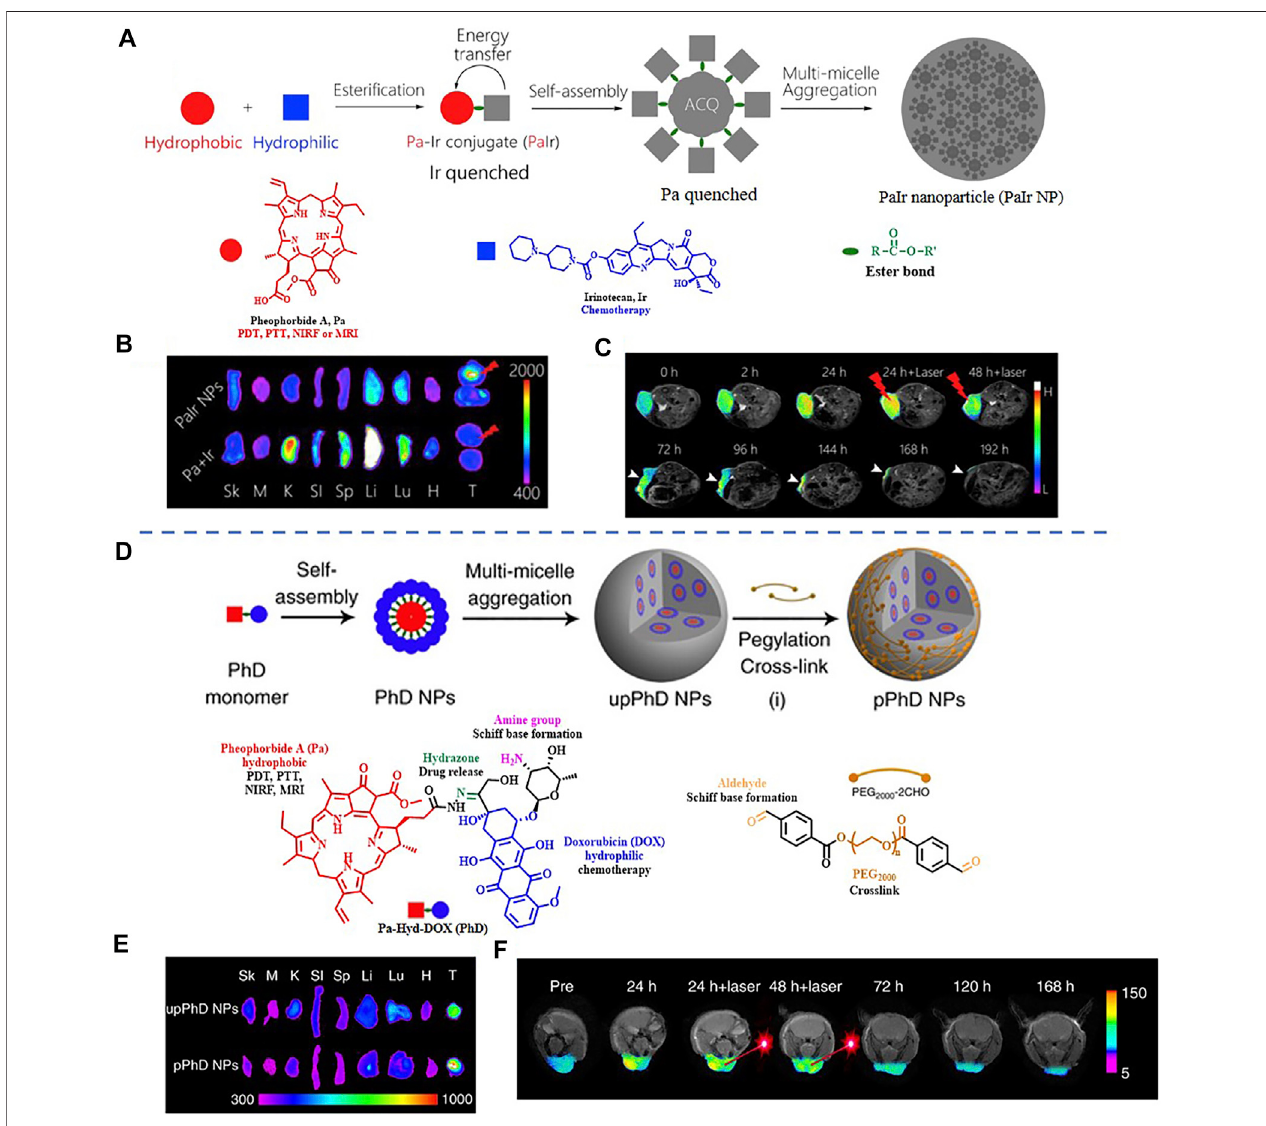
FIGURE 9 | (A) The fabrication of PaIr NPs. (B) Ex vivo distribution of PaIr NPs indicated by intrinsic NIRF. (C) Self-indication of the phototherapeutic effect by T 1 -weighted MRI. Reproduced with permission from Xue et al. (2018b). Copyright 2018, Elsevier. (D) Schematic illustration of the fabrication of pPhD NPs. (E) Ex vivo distributionofpPhDNPsindicatedbyintrinsicNIRF. (F) PhototherapeuticeffectmonitoredbyMRI.ReproducedwithpermissionfromXueetal.(2018a).Copyright2018,